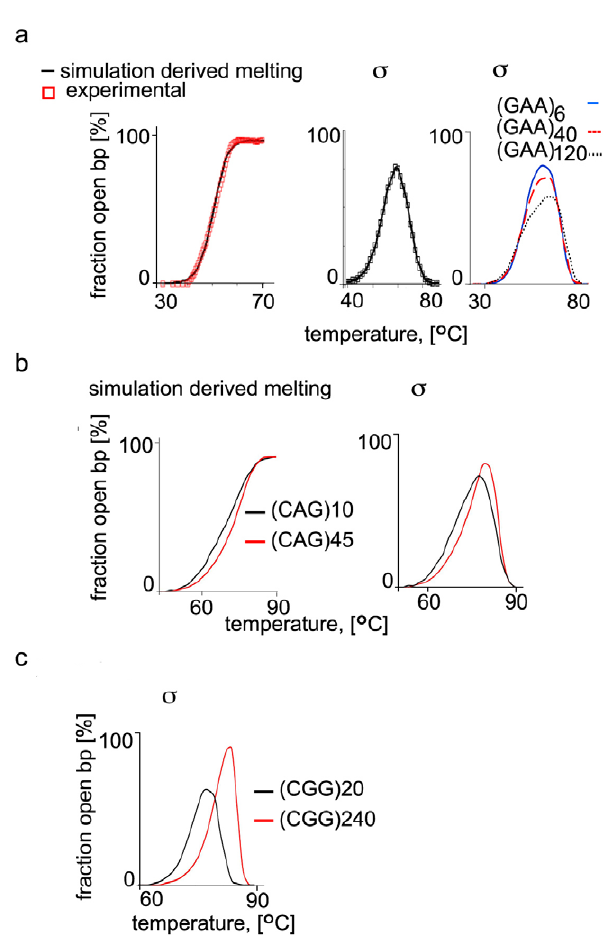
Figure 2. Formation of extended intermediate states in repeated sequences in response to temperature elevation. a) Melting behavior of the (GAA.TTC) 41 sequence and intermediate bubble state generation. MCMC simulated (black line) and measured (red squares) melting curve for the (GAA.TTC) 41 sequence at physiological salt concentration (100 mM KCl) is presented on the left . The theoretical fraction of the (GAA.TTC) 41 bases in the intermediate bubble states is calculated as well (panel in the middle ). The s values for (GAA.TTC) N of various lengths is compared and presented at the right . The sequences with a smaller number of repeats have higher, more pronounced s peaks that are shifted toward lower temperature when compared to the sequences with higher number of repeats. The identity of the repeats and the corresponding curves is shown at the top. b) Simulated melting behavior ( left panel) and intermediate bubble state s of 6 and 45 (CAG.CTG) repeats ( right panel). c) The intermediate bubble state s of 20 and 240 (CGG.CCG) repeats. The higher intermediate state is consistent with the collective behavior of the repeats. The s value is presented on the vertical as a fraction of open base pairs at a certain temperature (horizontal, u C). The total number of base pairs in the simulated individual sequences is taken as